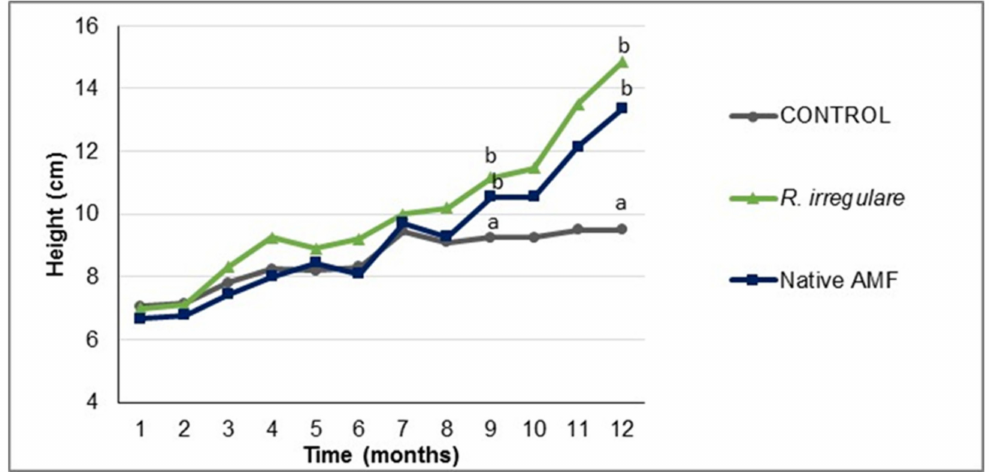
Figure 1. Growth of the Eriobotrya japonica plants mycorrhized with Rhizoglomus irregulare , with the native arbuscular mycorrhizal fungi (AMF) and non-mycorrhizal control plants. Each point indicates the average height (cm) of 10 plants. Data were statistically analyzed with one-way ANOVA. Di ff erent letters indicate significant di ff erences ( p ≤ 0.01) according to the Tukey